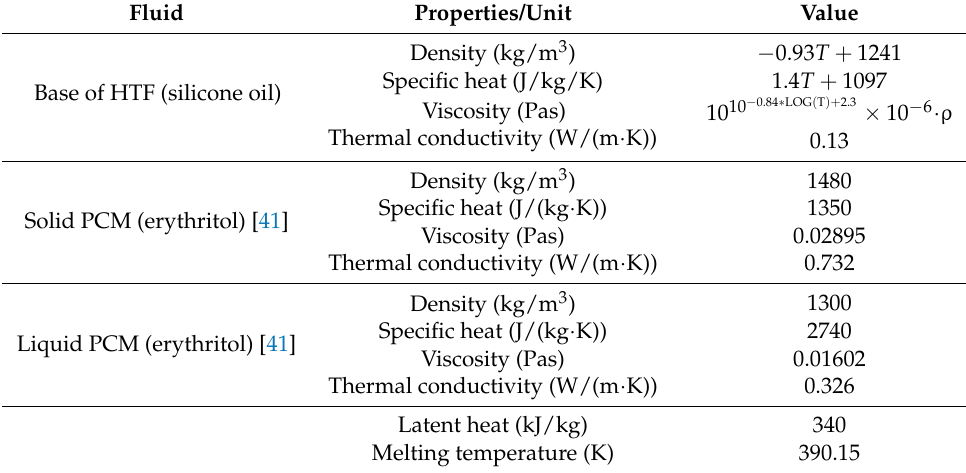
Table 2. Thermophysical properties of the PCM